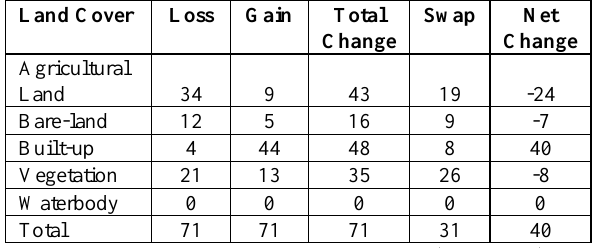
Table 3: Components of land cover transitions (1990-2020)